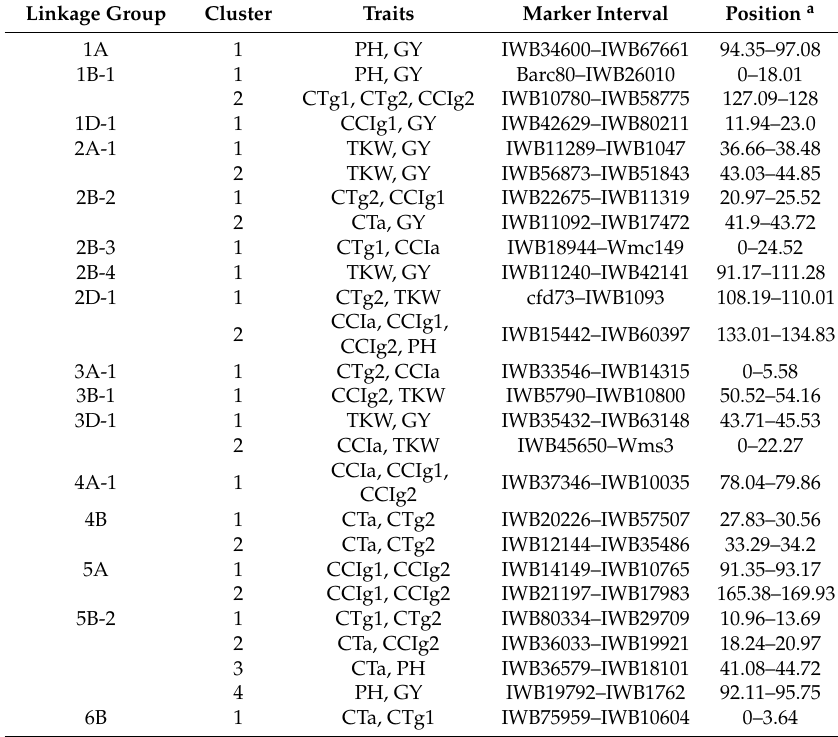
Table 8. Summary of pleiotropic QTLs identified in the SY Capstone/UI Platinum DH